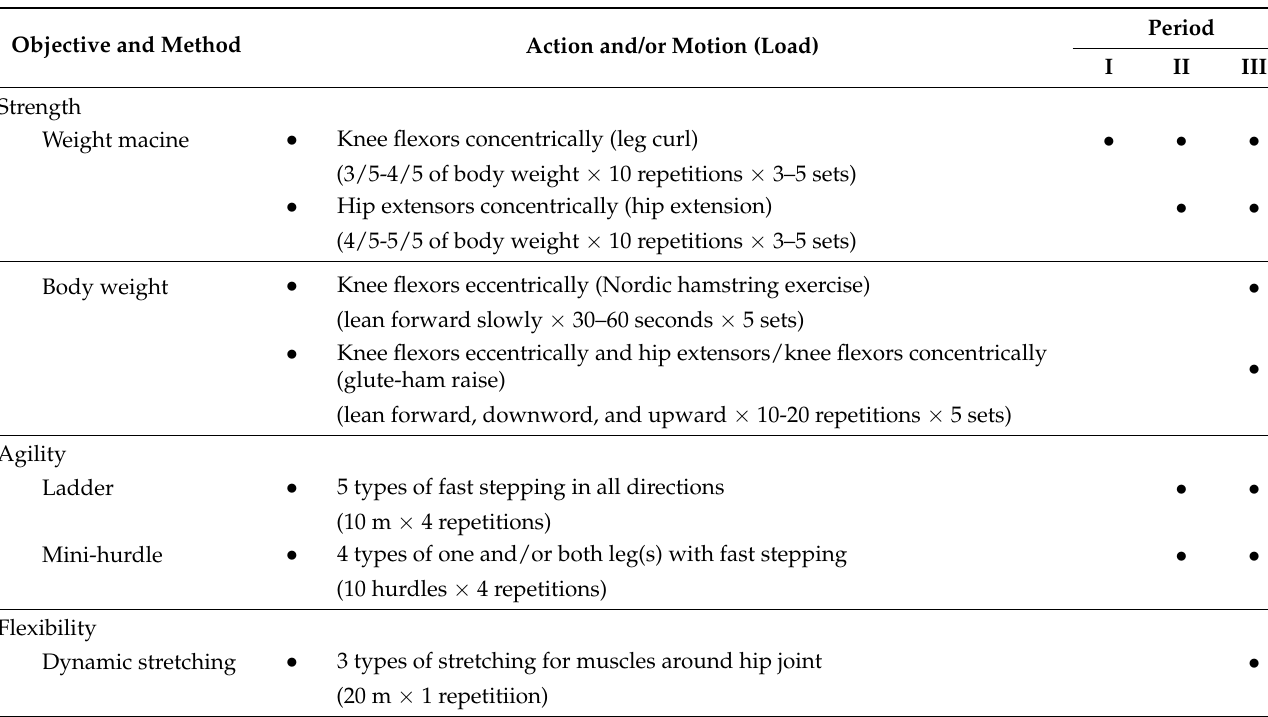
Table 3. Description of a preventive standard program for hamstring